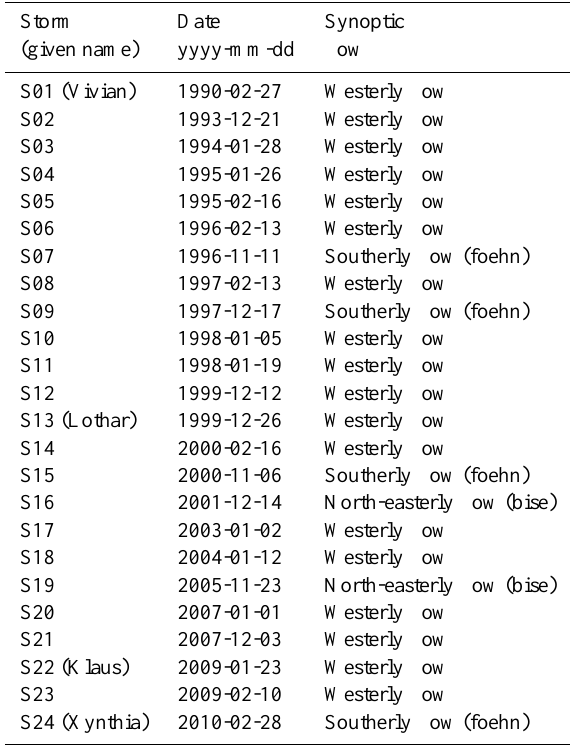
Table 1. List of 24 historical wind storms and the prevailing syn- optic flow conditions. This list is adapted from Table 1 in Etienne et al. (2013).